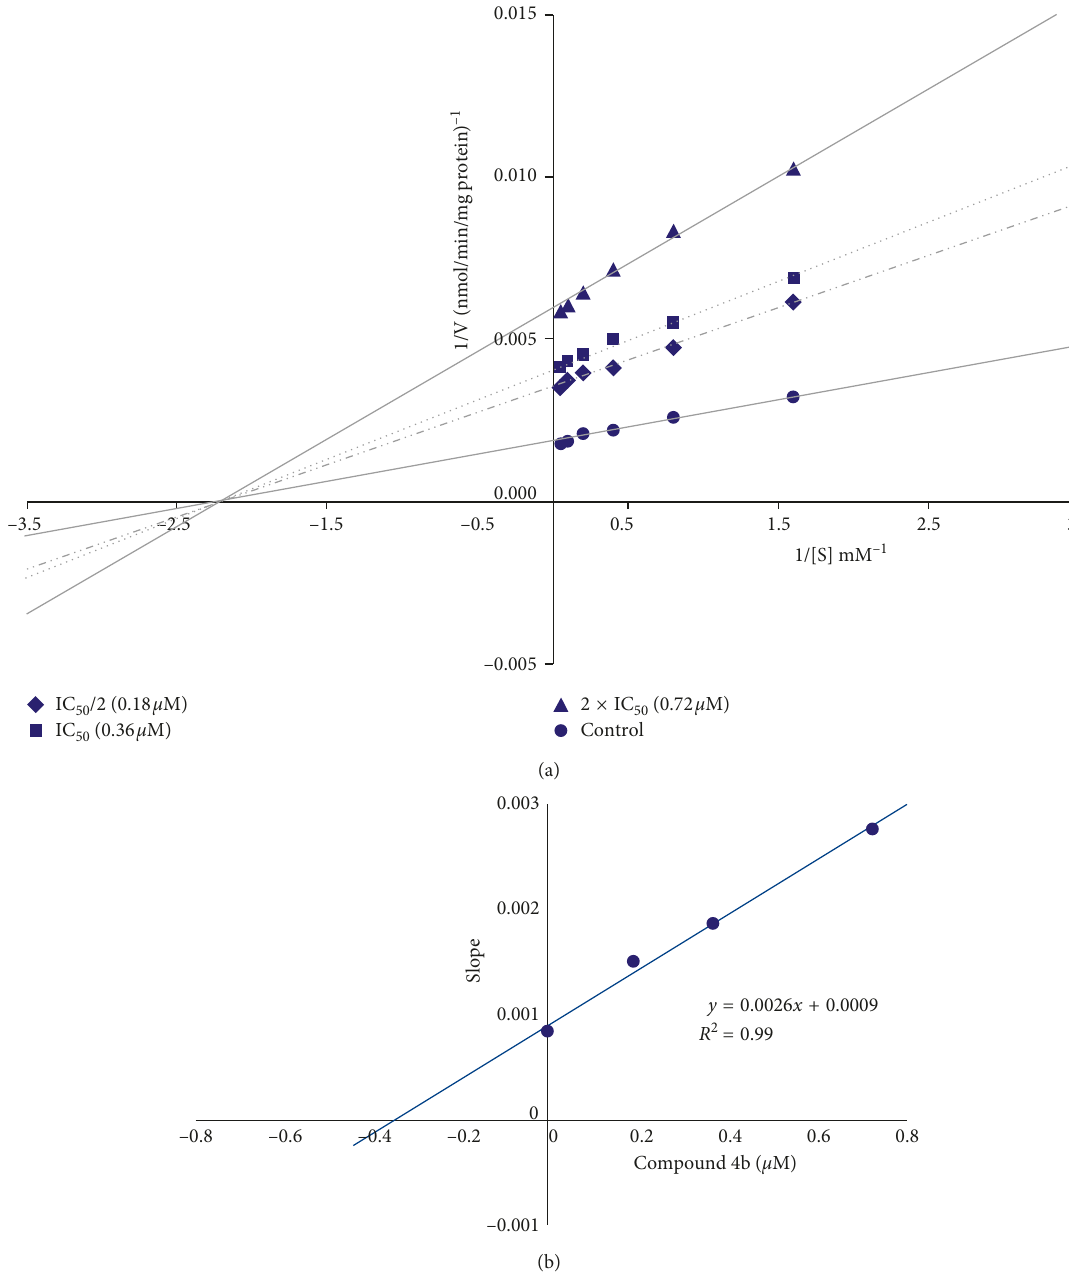
Figure 3: (a) Lineweaver–Burk plots for the inhibition of h MAO-B by compound 4b . [S], substrate concentration ( μ M); V, reaction velocity (nmol/min/mg protein). Inhibitor concentrations are shown at the left. V max values from 2xIC 50 to control: 172.565, 243.902, 277.778, and 525.120 (nmol/min/mg protein). K m value of the noncompetitive inhibition: 0.443 ± 0.018 ( µ M). (b) Secondary plot for calculation of steady-